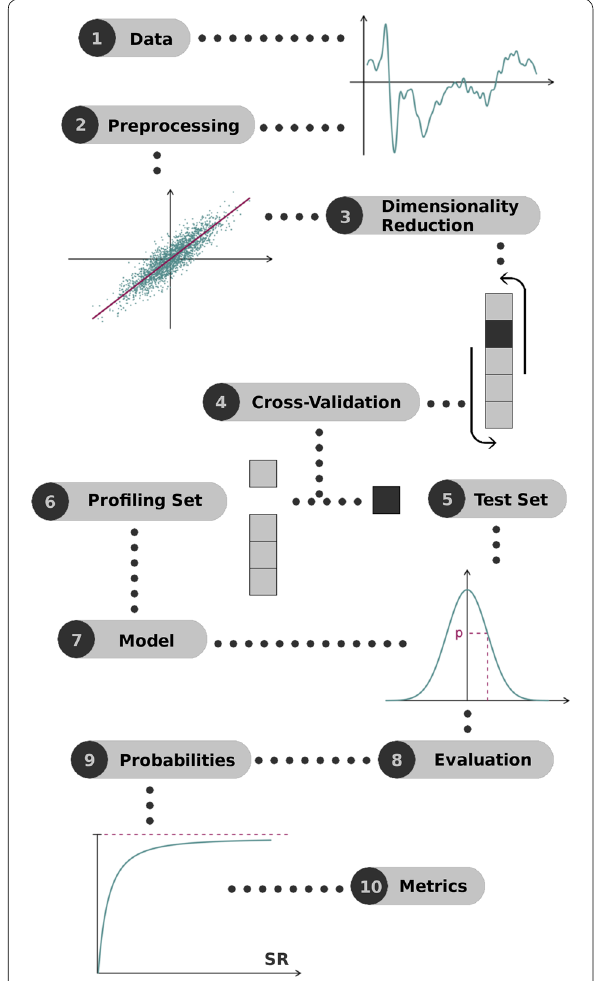
Fig. 1 Evaluation methodology